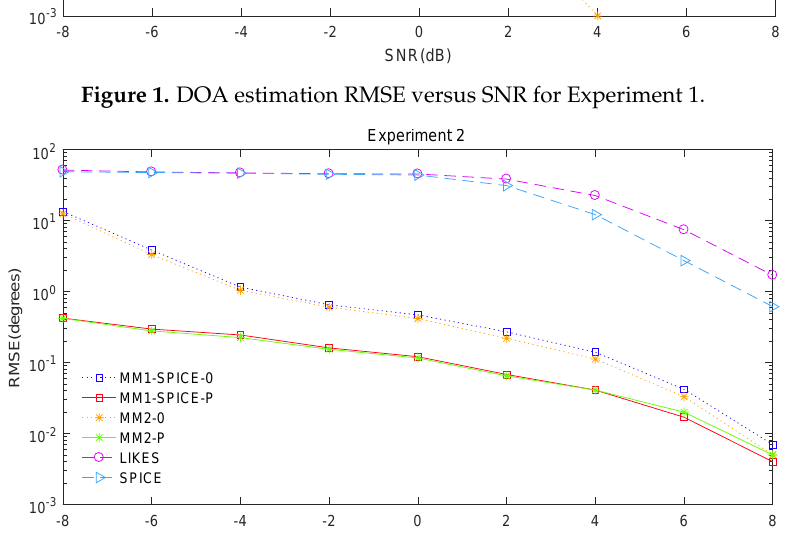
Figure 2. DOA estimation RMSE versus SNR for Experiment 2 with n = 100 and ∆ ξ = 15 ◦